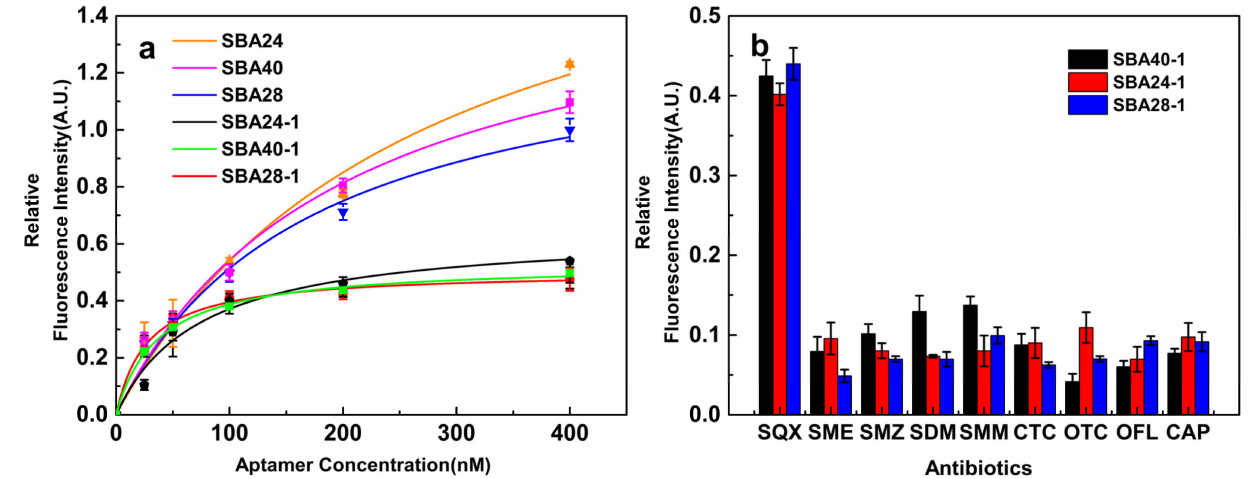
Figure 3. ( a ) Correlation between FAM-aptamer concentration and relative fluorescence intensity; ( b ) Relative fluorescence intensity of different structural antibiotics relative to SQX measured as the reference standard.